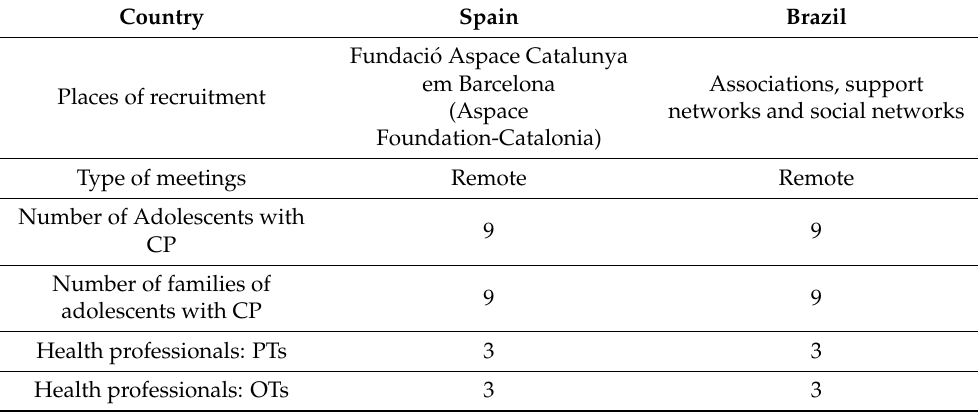
Table 1. Recruitment process that will be addressed in both countries.